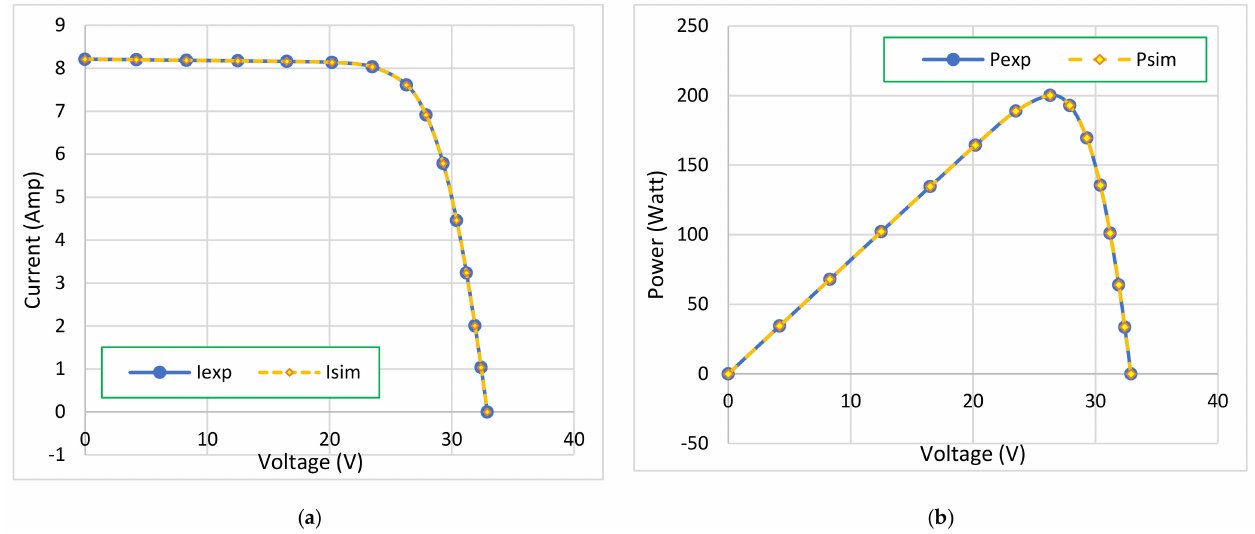
Figure 20. Characteristic curves for KC200GT DDM based on TFWO: ( a ) I–V ch/s and ( b ) P–V ch/s.